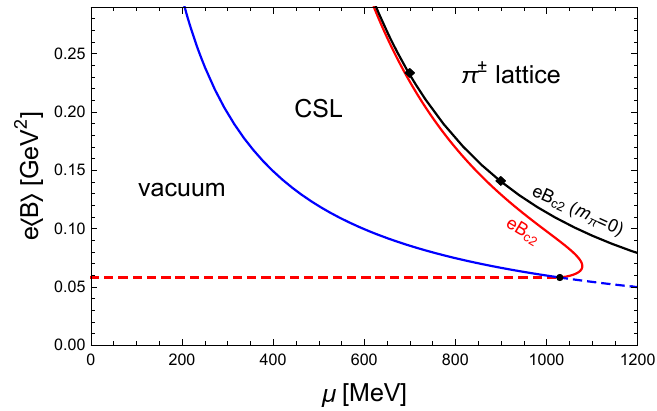
Figure 1 . Phase diagram in the e h B i - µ plane for a physical pion mass (red and blue curves) and in the chiral limit (black curve; in this case the vacuum only exists on the two axes). The solid blue curve marks the transition between the vacuum and the CSL phase. Just above the curve it is favourable to place a single domain wall into the system. The solid red curve indicates the instability of the CSL phase towards charged pion condensation at the critical field B c 2 . In this paper, we construct the resulting charged pion lattice in the chiral limit, in which case the critical field is given by the black curve. The two diamonds indicate the points at which we shall later plot the lattice structures. The dashed curves (instability of a single domain wall, red, and continuation of the vacuum/CSL transition curve, blue) are transitions between metastable phases. A first-order transition between the vacuum and the π ± lattice is expected somewhere between the dashed lines. Actual baryons in the form of nuclear matter are expected to compete with and possibly replace the phases at sufficiently large µ , but are omitted here and in the rest of the paper for simplicity. To put the scale of the magnetic field into context, note that within natural Heaviside-Lorentz units e h B i = 0 . 1 GeV 2 ’ 5 . 18 m 2 corresponds to e h B i ’ 5 . 12 × 10 18 G π